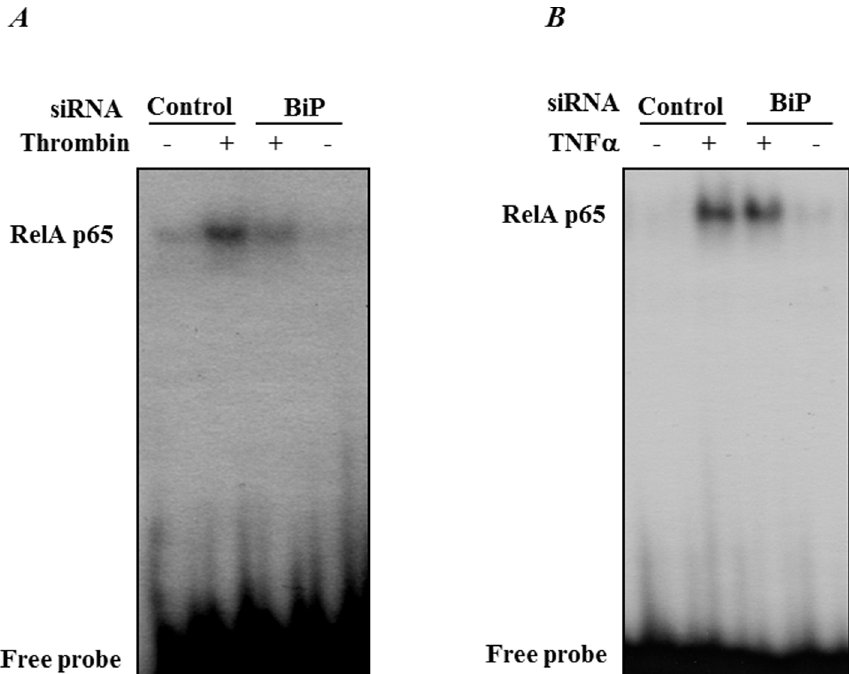
Figure 6. BiP knockdown blocks thrombin-induced RelA/p65 binding to DNA. HPAEC were transfected with control-siRNA or BiP-siRNA using DharmaFect1. After 24–36 h, the cells were challenged for 1 h with ( A ) thrombin or 0.5 h with ( B ) TNF a . Nuclear extracts were prepared and assayed for DNA binding of RelA/p65 by EMSA as described in the Materials and Methods. Results are representatives of two experiments.